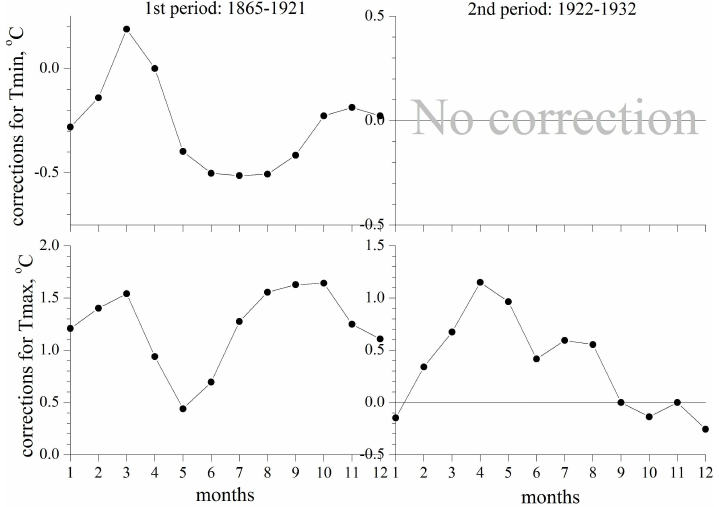
Figure 22. Coimbra: corrections (in ◦ C) for T min (top panels) and T max (bottom panels) series for two periods between the breaks; 1865–1921 (left panels) and 1922–1932 (right